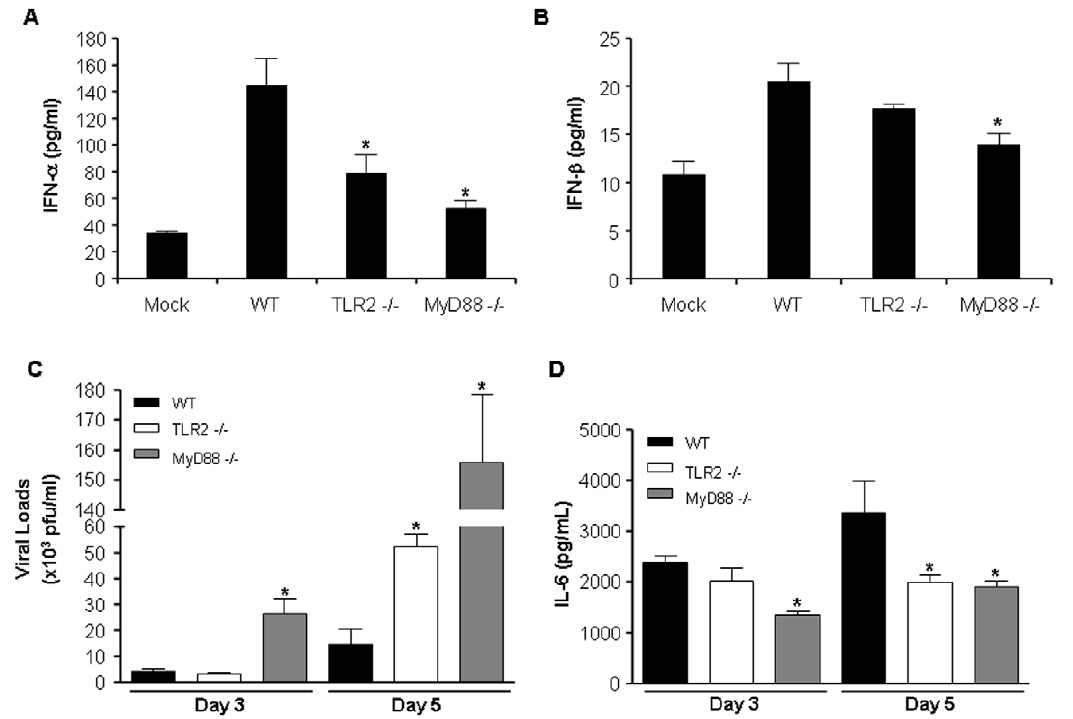
Figure 5. Decreased type 1 IFN and enhanced MHV-68 loads in lungs of TLR2- and MyD88-deficient mice. ( A and B ) WT, TLR2 2 / 2 and MyD88 2 / 2 mice (3 mice/group) were mock infected or infected in. with MHV-68 (10 5 PFU/mouse). Lung homogenates were prepared 24 hours post- infection for IFN- a ( A ) and IFN- b ( B ) determination by ELISA. ( C and D ) WT, TLR2 2 / 2 and MyD88 2 / 2 mice (5 mice/group) were infected in. with MHV-68 (10 5 PFU/mouse). Lung homogenates were prepared on days 3 and 5 post-infection for determination of viral load ( C ) and lung IL-6 concentration ( D ). Graphs are representative of three different experiments. Values significantly different ( p , 0.05) from WT mice are indicated (*).